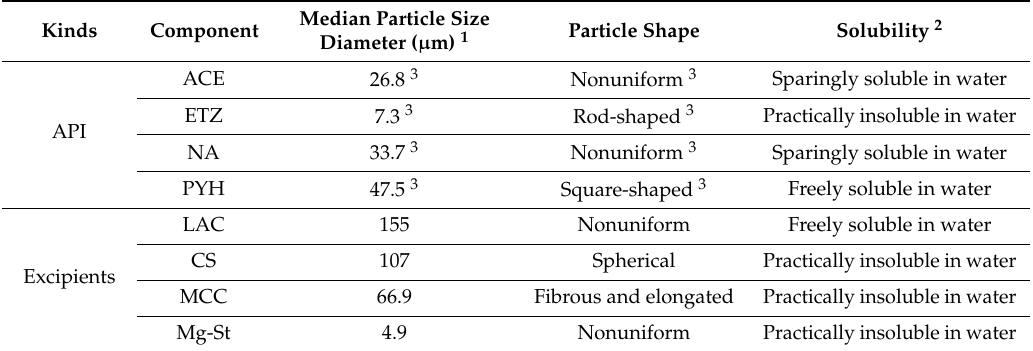
Table 1. Physicochemical properties of model active pharmaceutical ingredients (APIs) and excipients.